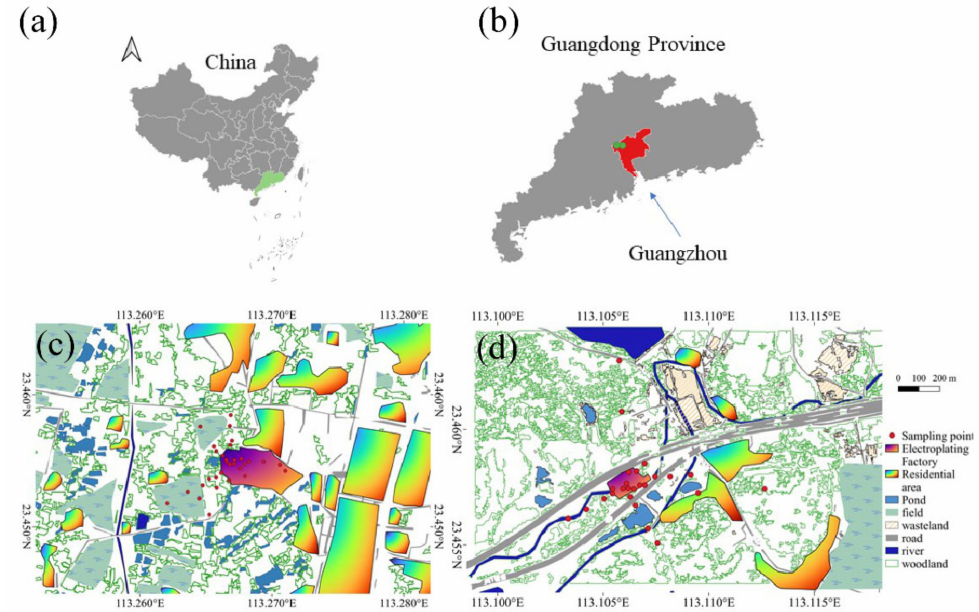
Figure 1. ( a ) Location of Guangdong province in China. ( b ) Location of Guangzhou in Guangdong province. ( c ) Map of Factory A and sampling sites. ( d ) Map of Factory B and sampling